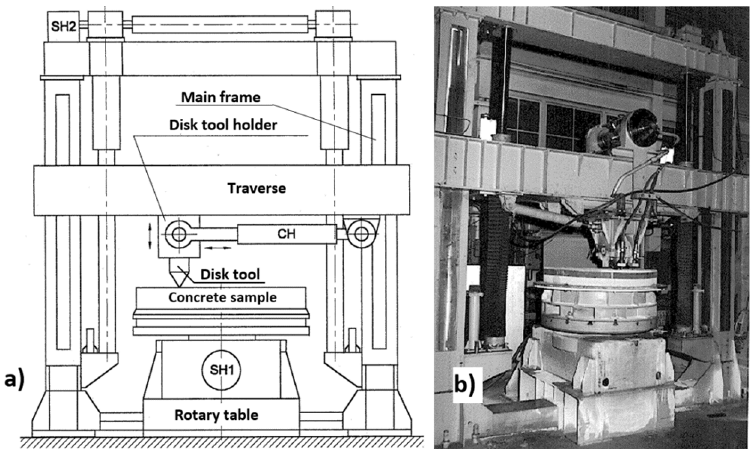
Figure 11. The test stand for testing single tools, preparing to mine the concrete sample with a disk